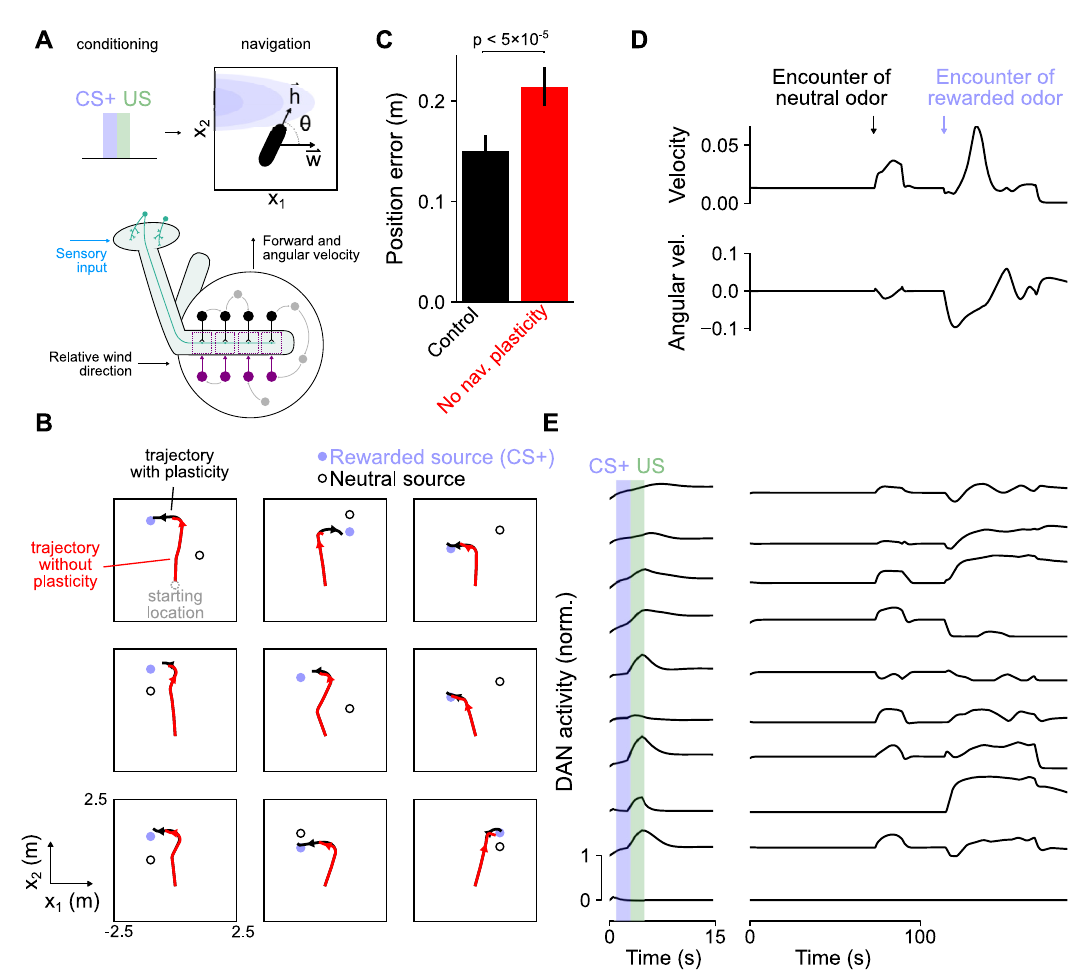
Fig 9. Model behavior for a navigation task. (A) Top: Schematic of navigation task. After conditioning, the simulated organism uses odor concentration input (blue) and information about wind direction w relative to its heading h . Bottom: Diagram of a network that uses these signals to compute forward and angular velocity signals for navigation. Velocity signals are read out from other neurons in the mushroom body output circuitry (gray), rather than output neurons. (B) Position of the simulated organism as a function of time during navigation. Black: Simulation with intact dopamine-gated plasticity during navigation; Red: Simulation with plasticity blocked. Arrowheads indicate direction of movement. In the top left plot, the starting location (gray circle) is indicated. (C) Position error (mean-squared distance from rewarded odor source at the end of navigation) for control networks and the same networks in which dopamine-gated plasticity is blocked during the navigation phase. For each network realization, error rates are computed over 50 test trials and bars represent s.e.m. over 30 network realizations. Significance is computed with a Wilcoxon signed-rank test. (D) Forward (top) and angular (bottom) velocity as a function of time during one example navigation trial. (E) Left: Dopamine neuron activity during CS and US presentation in the conditioning phase of a trial. Right: Dopamine neuron activity during the navigation phase of the trial (same trial as in D